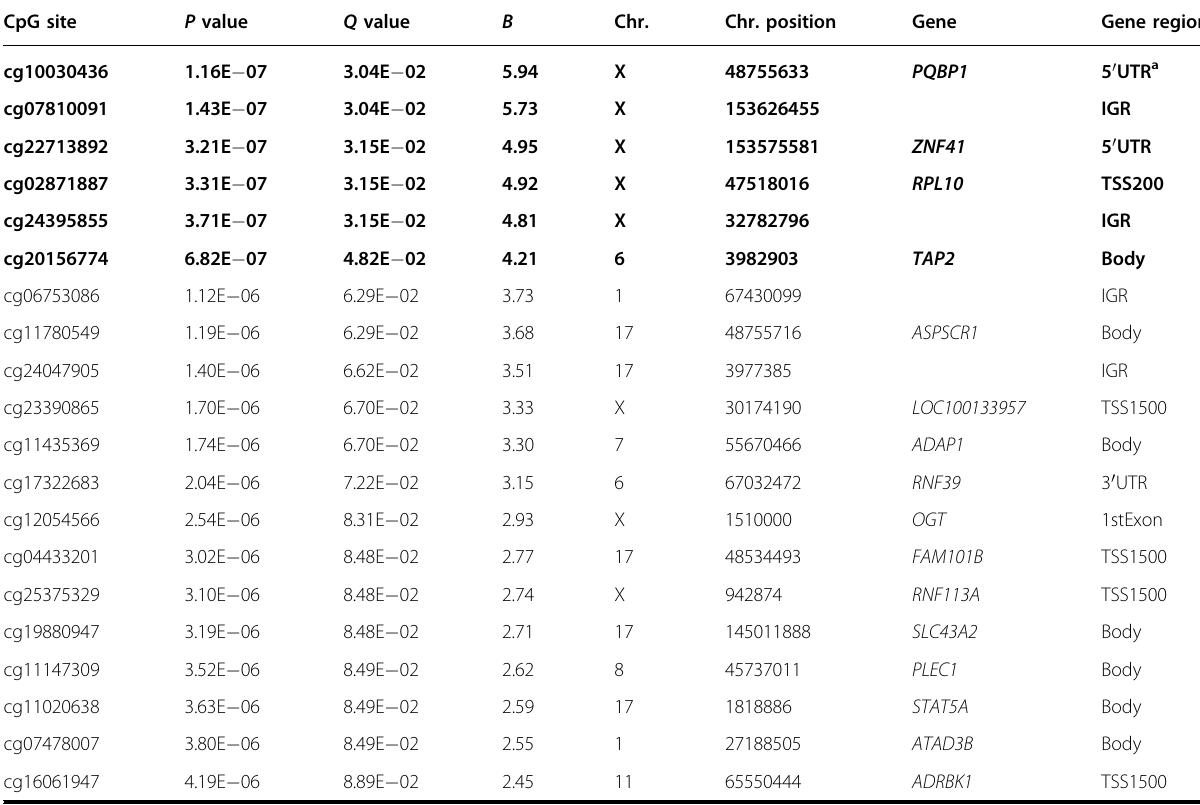
Table 1 Top 20 differentially methylated CpG sites resulting from the comparison between BPD ( N = 96) and CTL ( N = 44) methylation